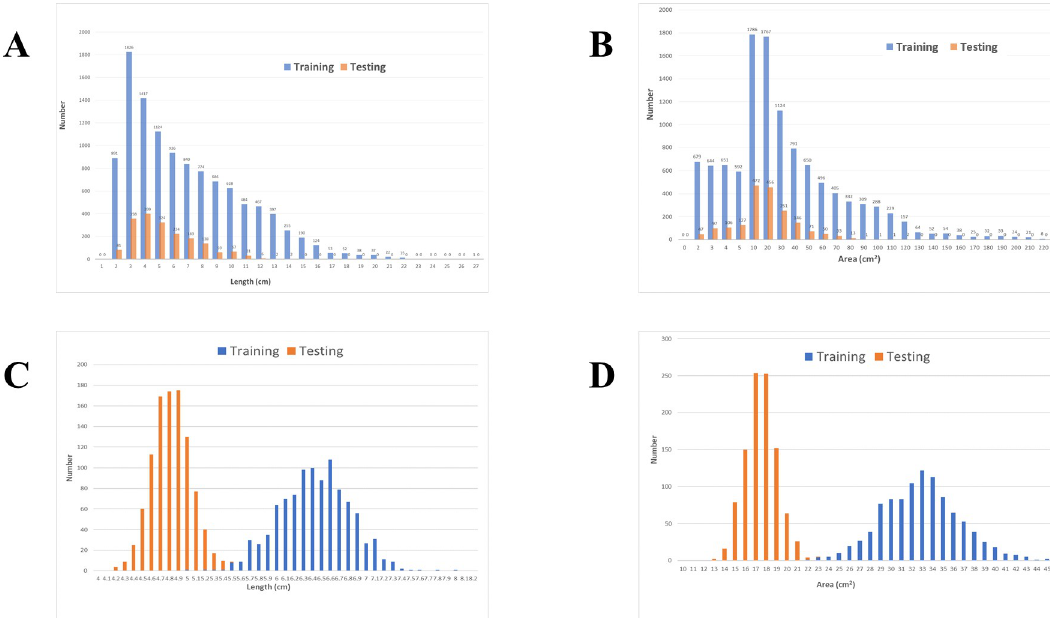
Fig 1. (A) Distribution of LDs of Abnormal Liver Density. (B) Distribution of areas of abnormal liver density. (C) Distribution of LDs after bootstrap resampling with a mean value of 100 samples repeated 1,000 times ( r = 0.9980, p < 0.0001). (D) Distribution of areas after bootstrap resampling with a mean value of 100 samples repeated 1,000 times ( r = 0.9988, p <